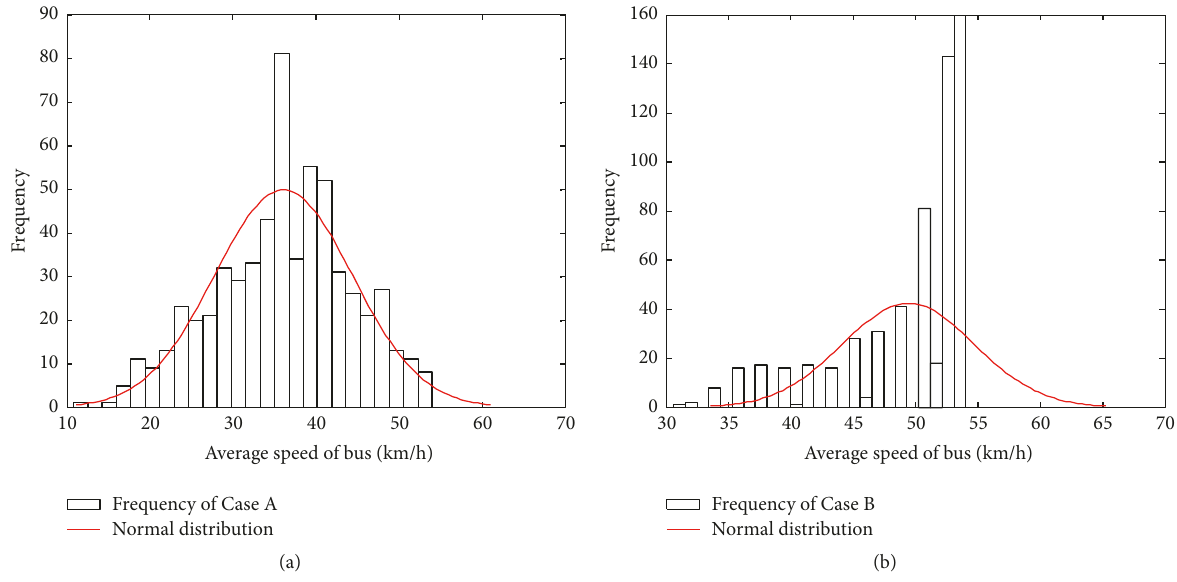
Figure 5: Histograms of average bus speed in Case A and Case B. (a) Histograms of average bus speed in Case A. (b) Histograms of average bus speed in Case